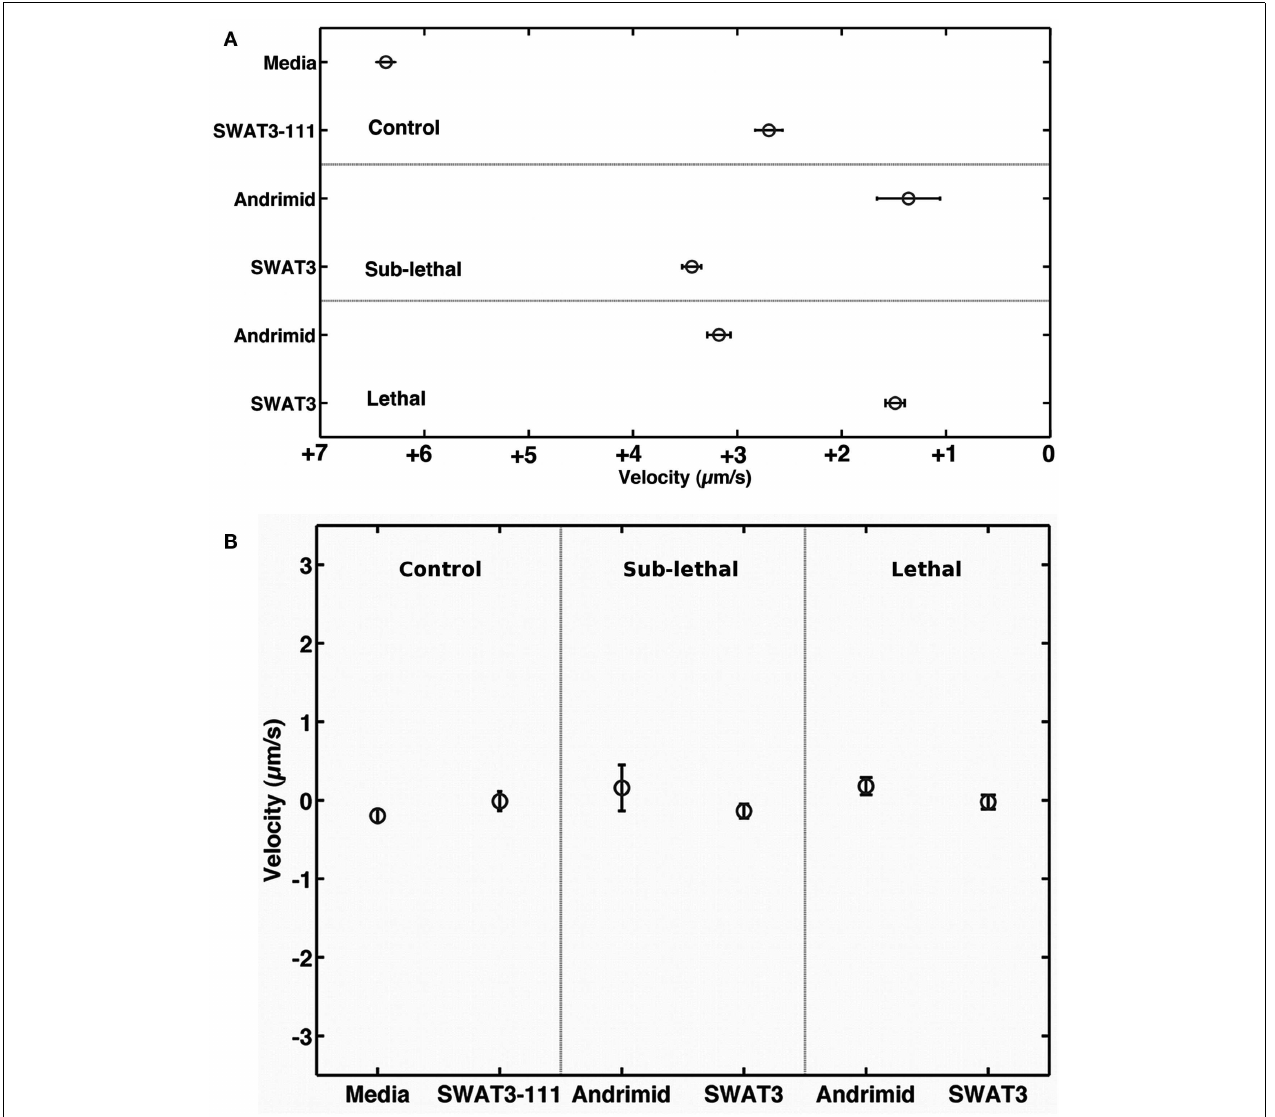
FIGURE 4 |Along and across gradient velocities. Mean velocity of V. cholerae in (A) the down and (B) cross-channel direction, i.e., parallel and perpendicular to the chemical gradient. Error bars represent 1 standard error of the mean.